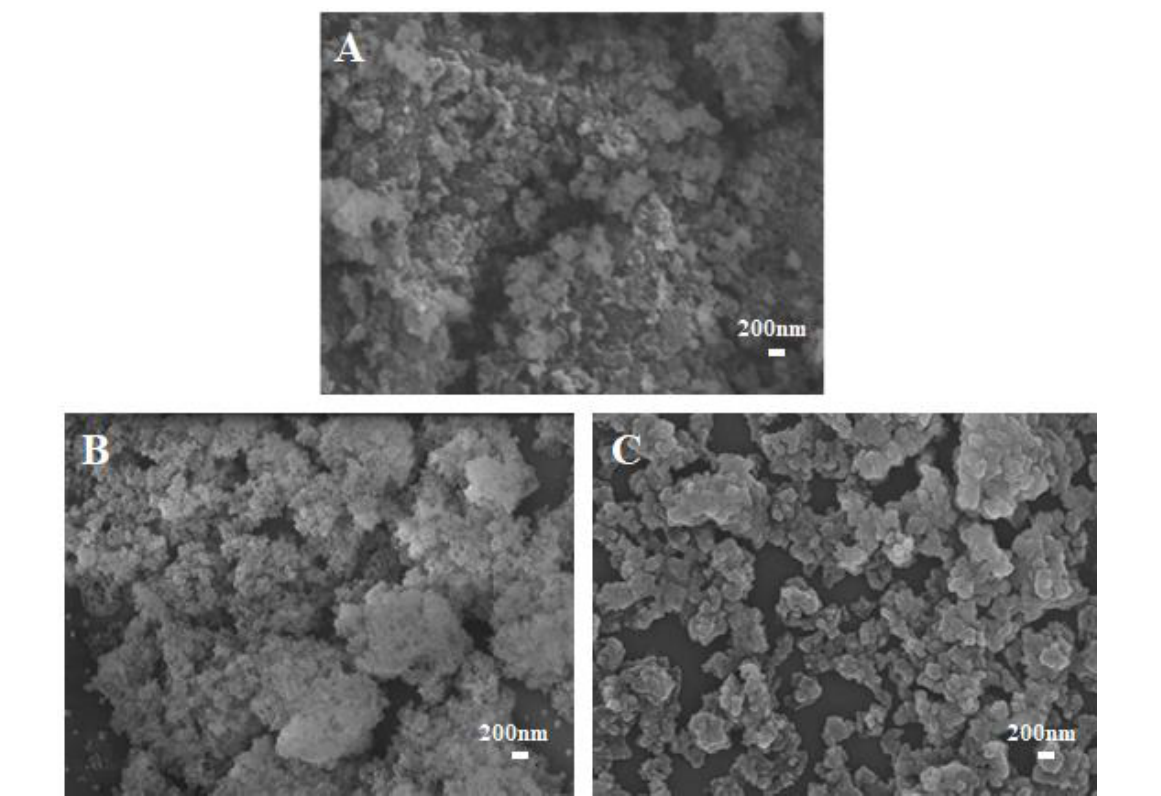
Figure 2. SEM images of SiO 2 and NPPDs dispersed in dodecane after 48 h: ( A ) SiO 2 ; ( B ) PM18/SiO 2 ; ( C ) PM18-g-NSiO 2 .